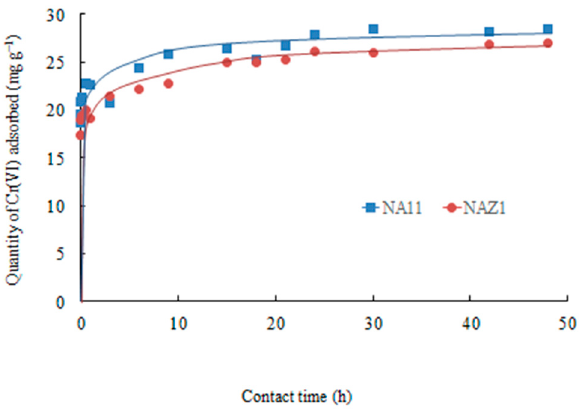
Figure 1. Effect of pH on the adsorption of Cr(VI) using NA11 and NAZ.